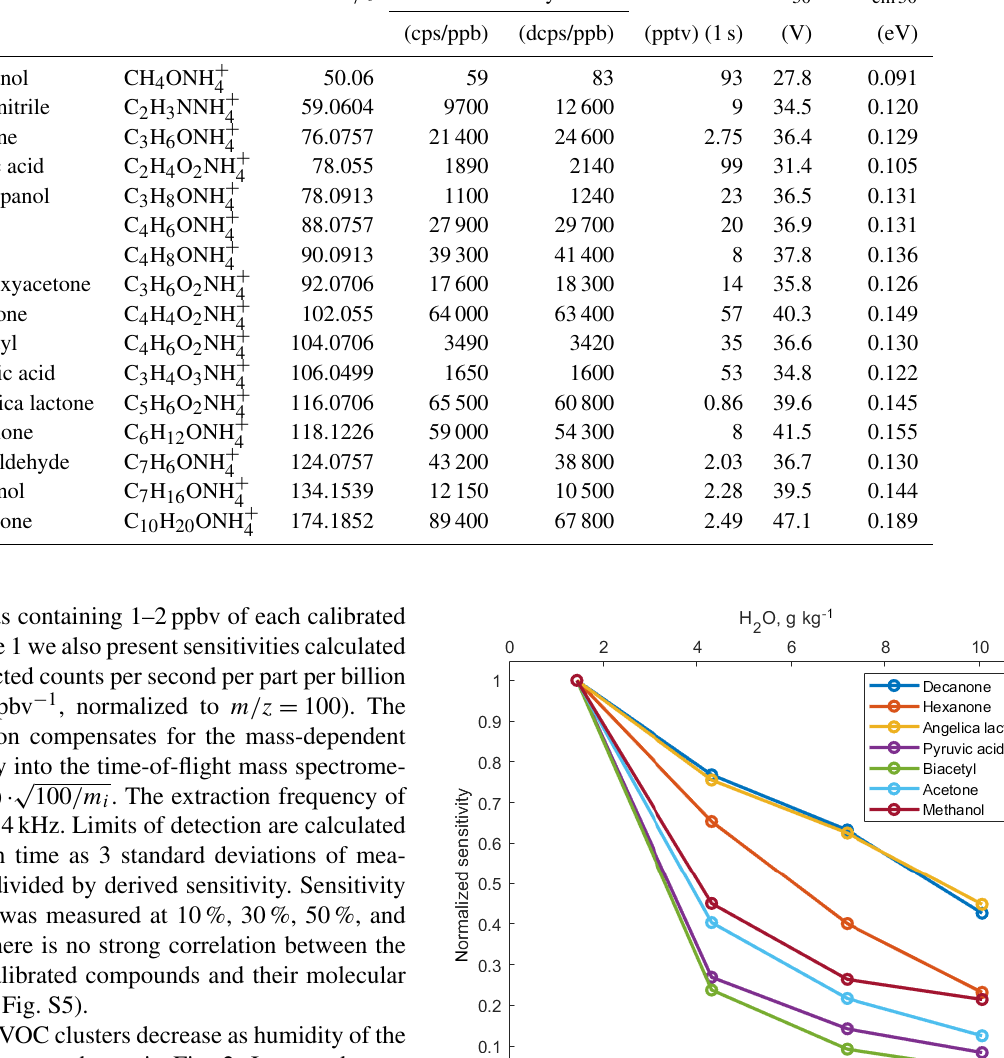
CIMS for various VOC species, voltage ( V 50 ), and corresponding kinetic energy (KE cm50 ) 4